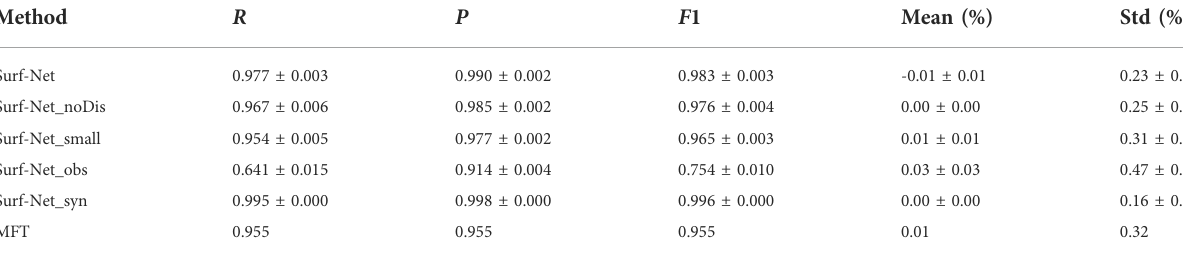
TABLE 1 Performance for single picks in the synthetic test set. The threshold is set to